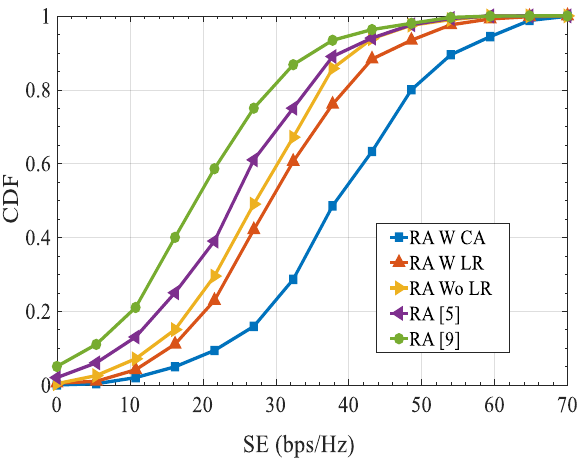
Figure 5. Cumulative Distribution Function (CDF) of spectral efficiency (SE) performance.